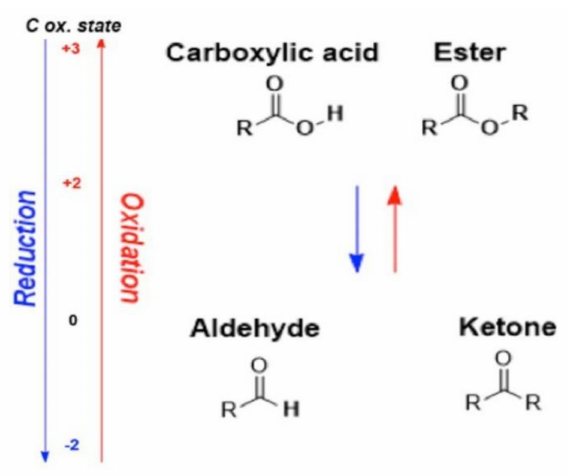
Figure 14. Scheme of the reduction of carboxylic and ester chemical groups to aldehydes and ketones.